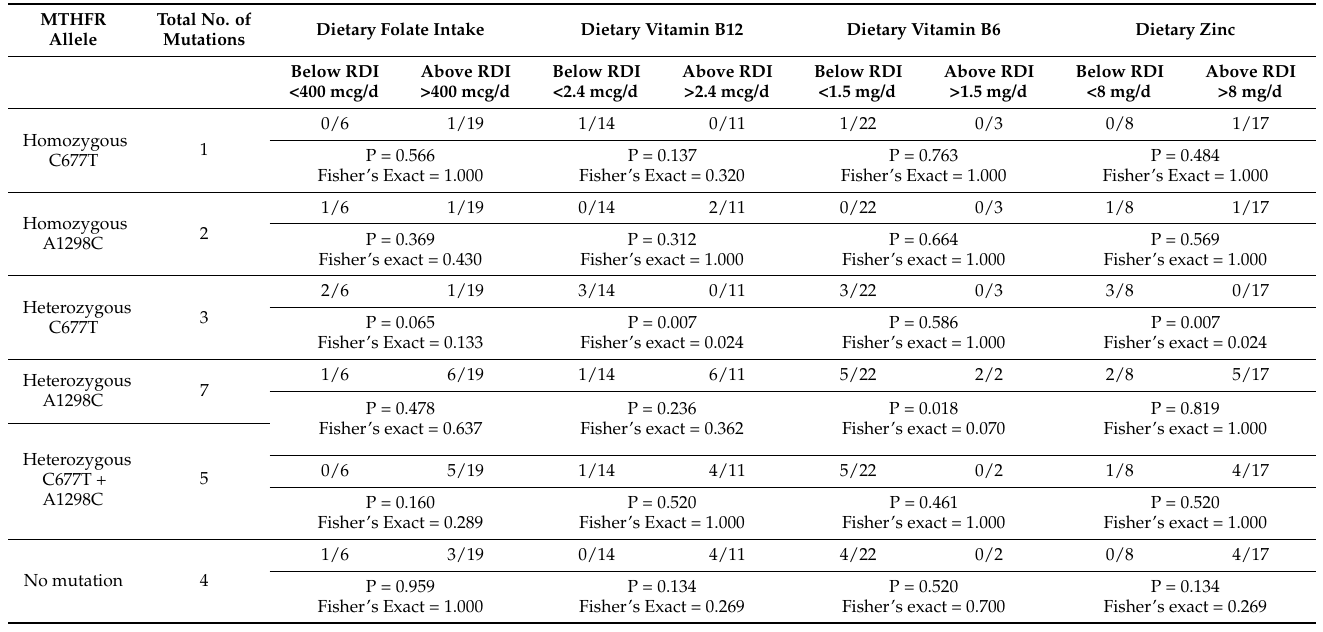
Table 6. MTHFR mutations and dietary intakes: Using a two-way table of association using Pearson’s chi-squared significance and Fisher’s exact test for association of each MTHFR mutation on dietary intakes of nutrients.